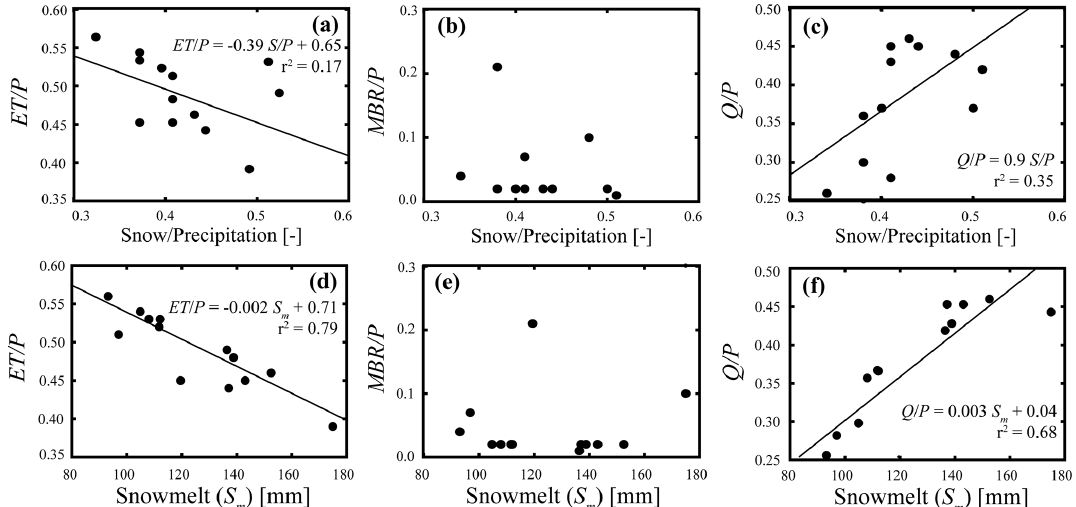
Figure 11. Scatterplots illustrating the relation between the annual snow / precipitation ratio and ET /P (a) , MBR /P (b) , and Q/P (c) ratios for WY2016. We also present the relation between the total annual snowmelt ( S m ) and the ET /P (d) , MBR /P (e) , and Q/P (f) ratios. Each point represents the value for the Kaweah Terminus watershed from each of the forcing scenarios in experiments 1–3. Black lines represent statistically significant ( p < 0 . 05) linear relationships.